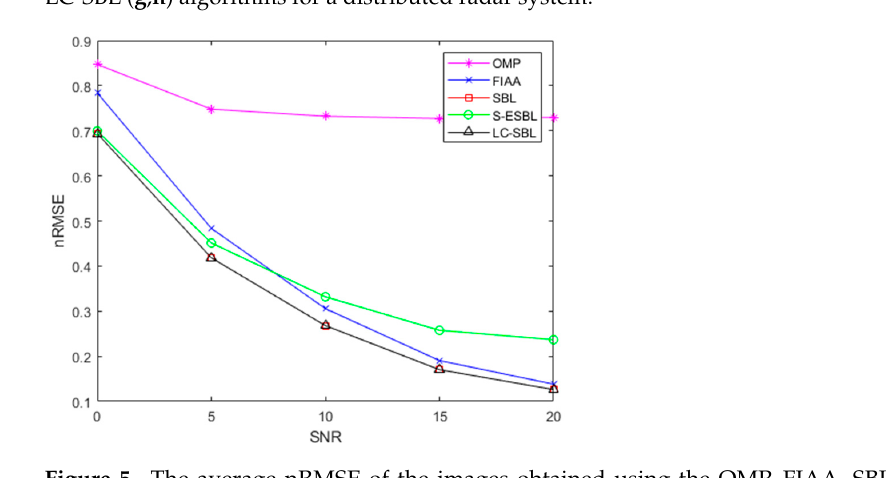
Figure 5. The average nRMSE of the images obtained using the OMP, FIAA, SBL, S-ESBL and LC- SBL algorithms. Table 1. The average computational times of the OMP, FIAA, SBL, S-ESBL and LC-SBL algorithms with a 10 dB SNR.